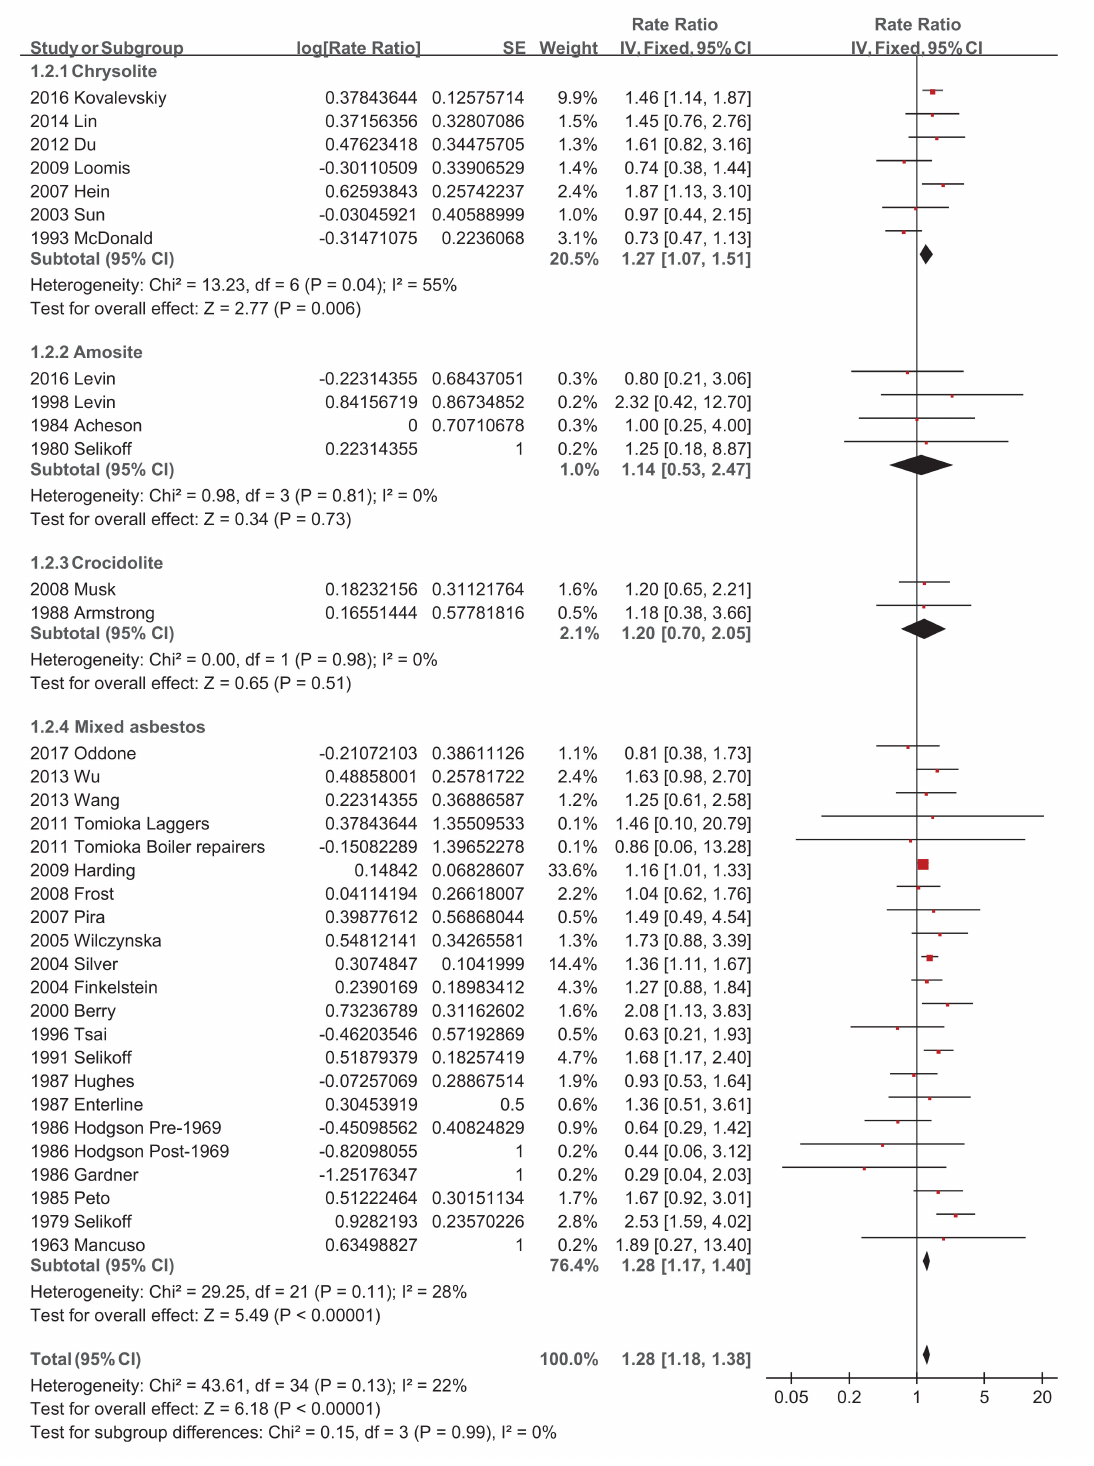
Figure 4. Subgroup analysis of SMRs of esophageal cancer based on the type of asbestos